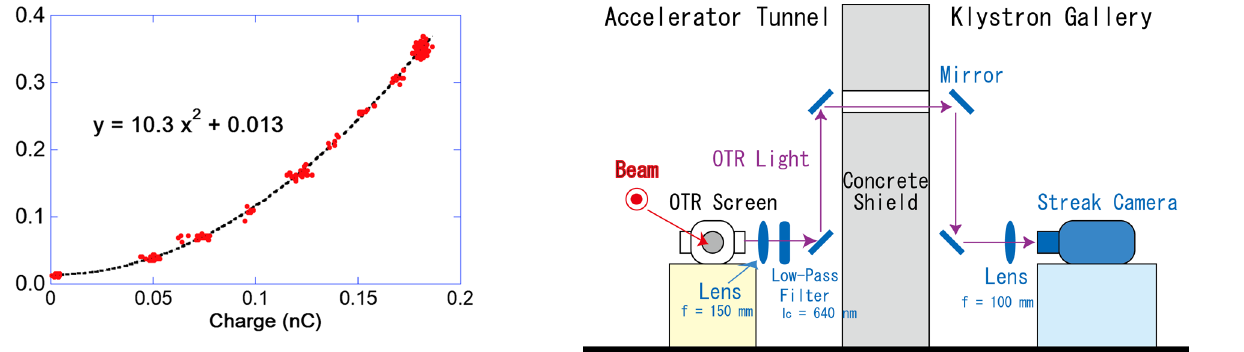
FIG. 24. Experimental setup of an electron bunch-length mea- surement using OTR light and a streak